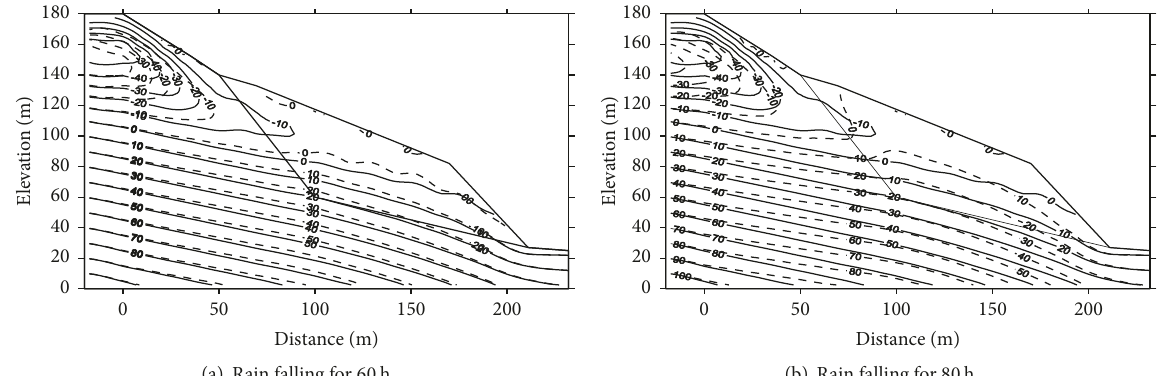
Figure 12: Pressure head contours for coupling (dashed line) and uncoupling (solid line) (20 mm/h).